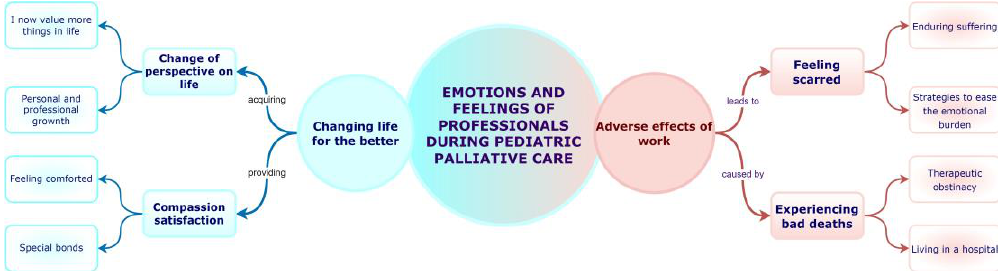
Figure 1. Conceptual map of the study findings.